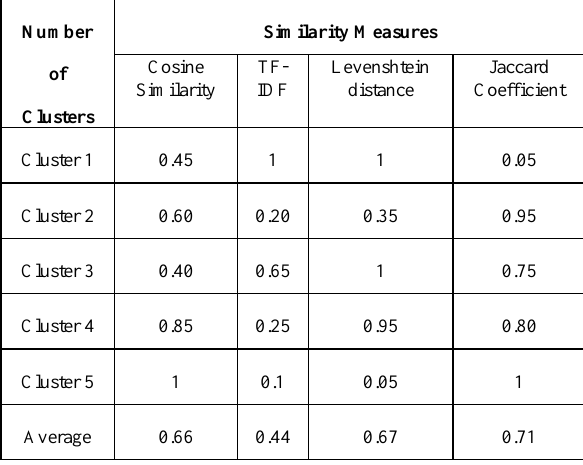
Table 11 described the result of five clusters by different techniques of similarity measures before pre-processing.